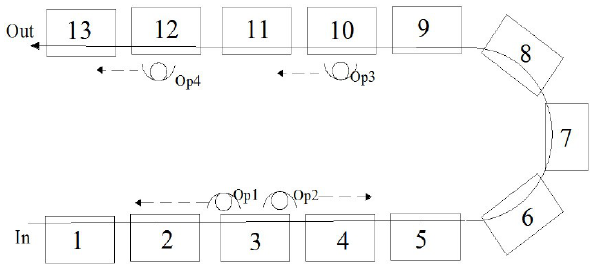
Figure 4. Toyota Sewing System